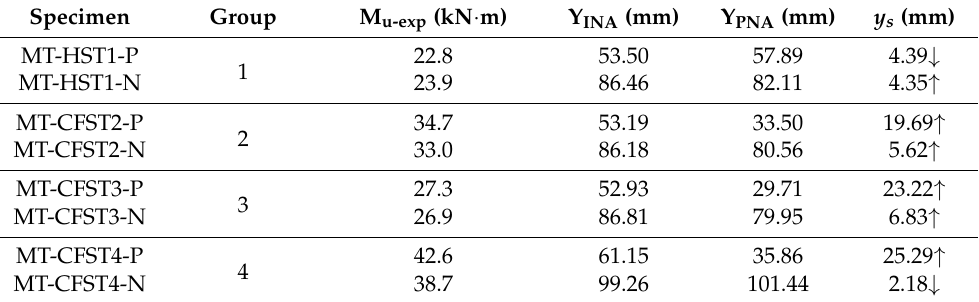
Table 2. Ultimate bending moment and shifting values between initial neutral axis and plastic neutral